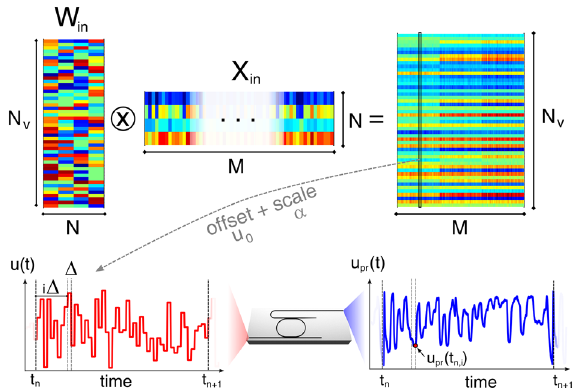
Figure 1. Process flow of the encoding of the input signal. M input samples { x ( 1 ) , . . . , x ( M ) } of dimension N are queued on the columns of a matrix X in . The dimension of each sample is then increased to N v using a connectivity matrix W in . A global offset u 0 is applied to W in X in to remove the negative values, and a multiplicative scale factor α is applied. The resulting column values represent the input pump power (red curve) u of each sample, which are sequentially injected at times t n = n ( N v �) at the input port of the MR (central inset). Similarly, the values of the probe power u pr ( t n , i ) at times t n , i = n ( N v �) + i � , with i = { 1, . . . , N v } , define the virtual nodes at the output of the Drop port of the